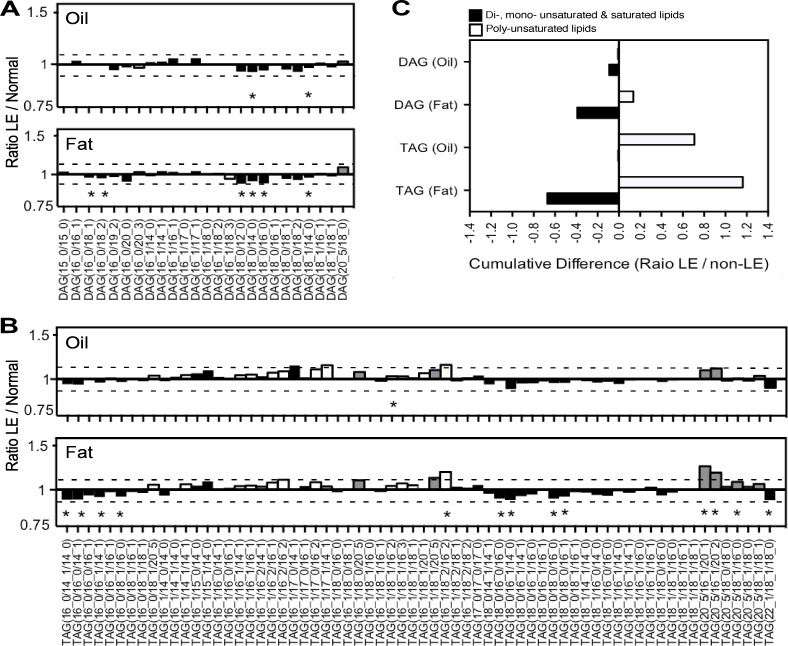
AT Diacylgleycerides (DAGs) and Triacyglycerides (TAGs).(A) DAG lipids and (B) TAG lipids in LE AT versus cosmetic surgery AT lipoaspirate fat (Fat) or the liquid fat oil (Oil). Data shown are ratios of LE compared to Normal non-LE AT, calculated from means ± SD of log transformed median-normalised relative abundance. Dotted line indicates ± 0.1-fold difference; Poly-unsaturated lipds with ≥ 3 unsaturated bonds (white fill) or containing C20:5-based lipids (grey fill), compared to saturated, mono- or di- saturated lipids (back fill). Statistical significance as noted (*), p < 0.05, based on two-tailed unpaired students t-test, irrespective of whether the difference is ±0.1 with respect to normal AT. (C) Total number of poly-unsaturated versus combined unsaturated plus mono- or di- unsaturated lipids in LE and non-LE oil and fat AT.